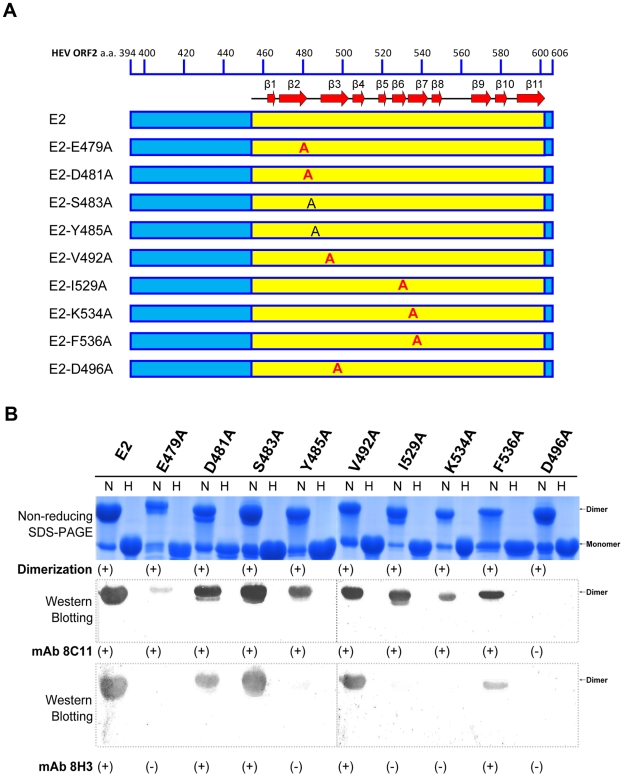
Mutational studies on the groove region.
(A) The schematic representation of wild-type E2 and nine point mutations targeting the solvent-accessible residues near the groove region. (B) The wild type E2 and its mutants were subjected to non-reducing SDS-PAGE and Western Blotting with the HEV-neutralizing antibody 8C11 or 8H3. In this figure the lanes with H indicate samples in the reduced condition (i.e. these samples were heated up to 100°C for 3 minutes). These samples were mainly resolved as monomers. The lanes with N indicate samples in the non-reducing condition (i.e. these samples with 0.1% SDS, no BME and were not heated). These samples were resolved mainly as dimers. All nine mutants remained as dimers. Western Blotting showed that the dimeric E2 wild type and eight mutants were reactive with mAb 8C11. Of these, only E479A, Y485A, I529A, K534A and D496A abolished the 8H3 reactivity. Interestingly, mutant D496A abolished the HEV neutralizing antibodies 8C11 and 8H3 reactivity while maintaining the dimeric arrangement.